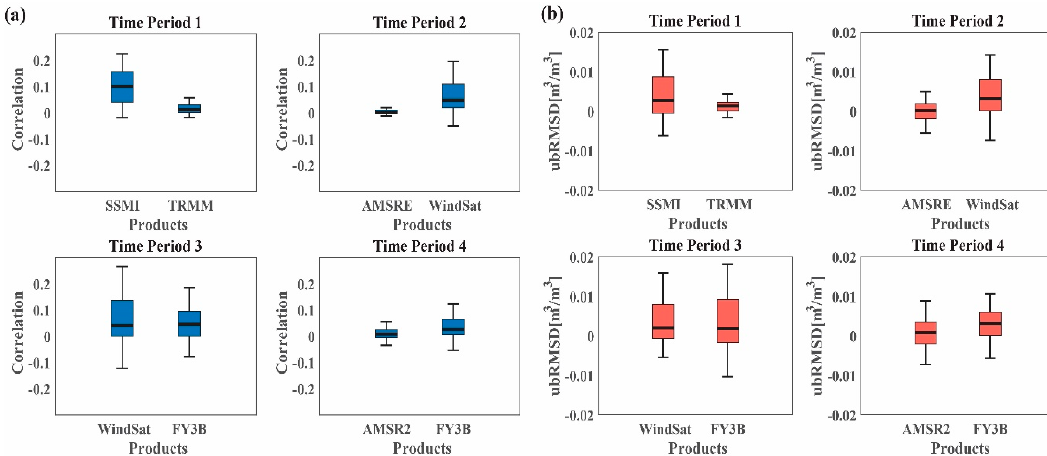
Figure 4. Evaluation of improvements within the merged product based on differences in ( a ) correlation coefficients and ( b ) unbiased root mean square difference (ubRMSD) with the parent products relative to the International Soil Moisture Network (ISMN) datasets. Positive (+) values indicate higher qualities in the merged while negative (-) values indicate higher qualities in the parent products.